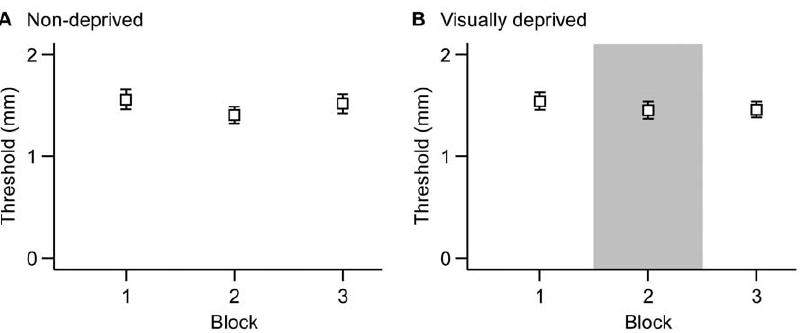
Figure 7. Experiment 3 data. GOT performance (mean 76% threshold) of the two groups: A, non-deprived (n=29 participants). B, visually deprived (n=32 participants). The shaded rectangle in B delineates the visual deprivation period. Error bars represent 6 1 SEM.